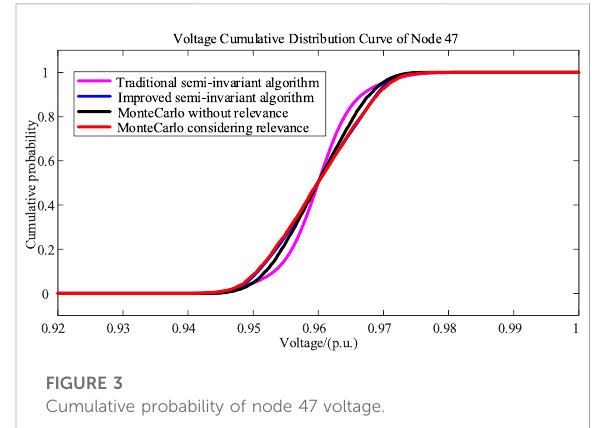
FIGURE 3 Cumulative probability of node 47 voltage.